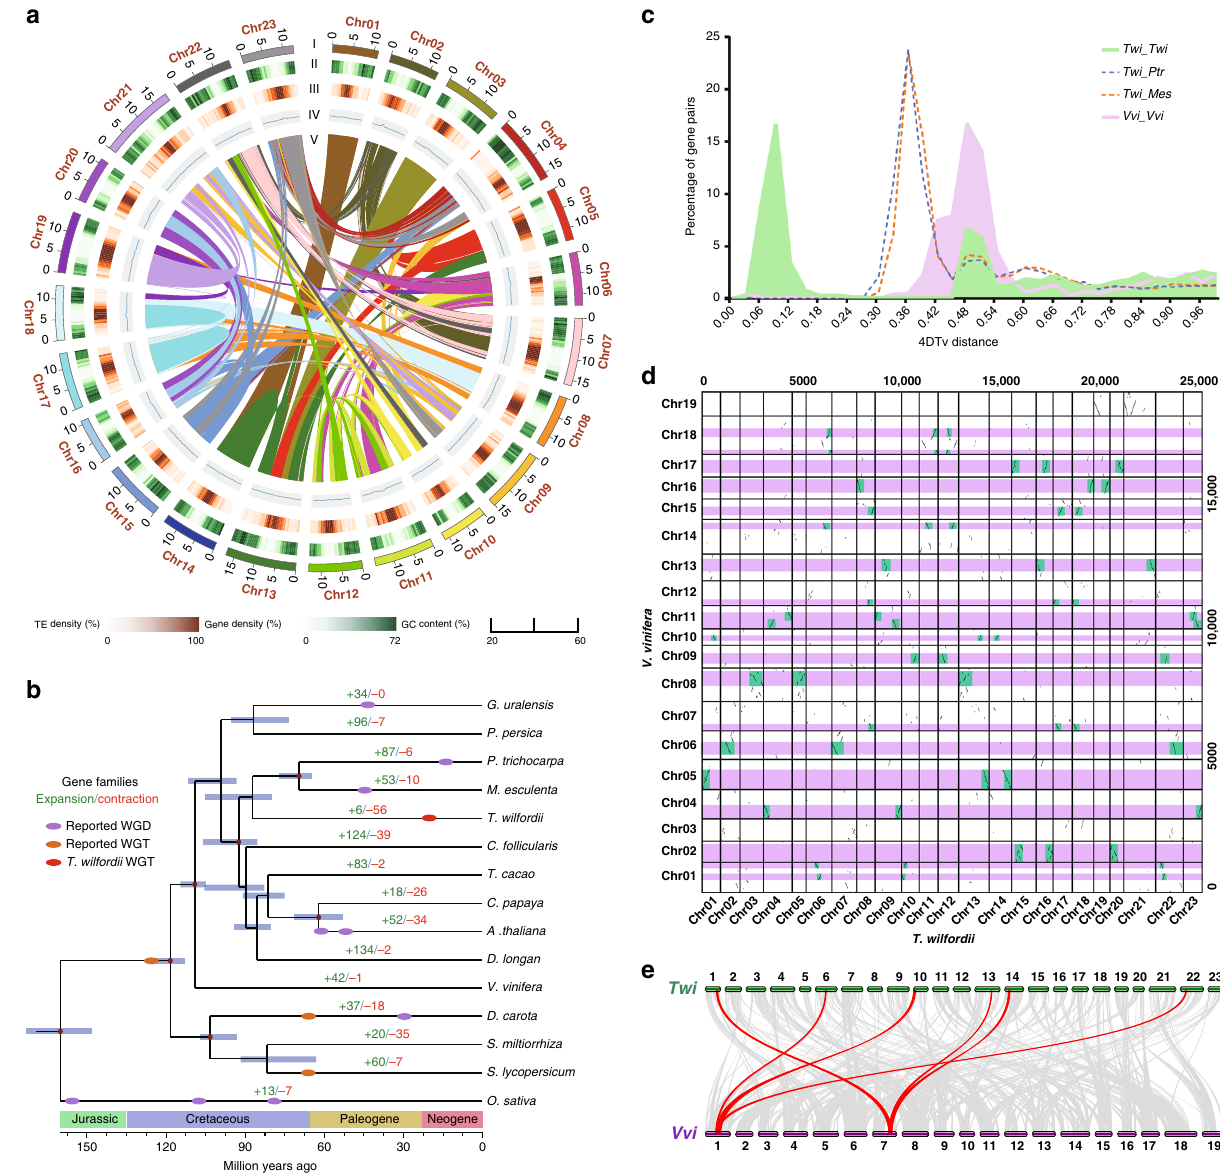
Fig. 1 Genome evolution of T. wilfordii . a Distribution of T. wilfordii genomic features. (I) Circular representation of the pseudomolecule. (II – IV) gene density (500 kb window), percentage of repeats (500 kb window), and GC content (500 kb window). (V) Each linking line in the center of the circle connects a pair of homologous genes. b Inferred phylogenetic tree with 514 single-copy genes of 15 plant species. Gene family expansions are indicated in green, and gene family contractions are indicated in red. The timing of whole-genome duplication (WGD) and the timing of whole-genome triplication (WGT) are superimposed on the tree. Divergence times are estimated by Maximum Likelihood (PAML). c Distribution of 4DTv shown in colored lines as indicated. d Syntenic dot plots show a 3 – 1 chromosomal relationship between T. wilfordii genome and V. vinifera genome. e Macrosynteny between T. wilfordii and V. vinifera karyotypes. Source data are provided as a Source Data fi